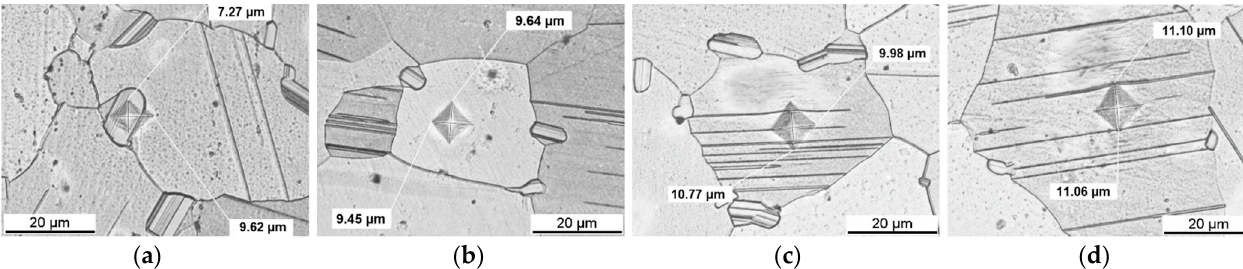
Figure 9. Optical micrographs of Mg ‐ Dy ‐ Nd ‐ Zn ‐ Zr alloy in the solution heat ‐ treated condition at 500 °C for 48 h with HV0.005 indents in: blocky LPSO ( a ), grain without matrix LPSO lamellae ( b ), grain with matrix LPSO lamellae, where lamellae are indented ( c ) and grain with matrix LPSO lamellae, where the indent sits in between the lamellae ( d ).